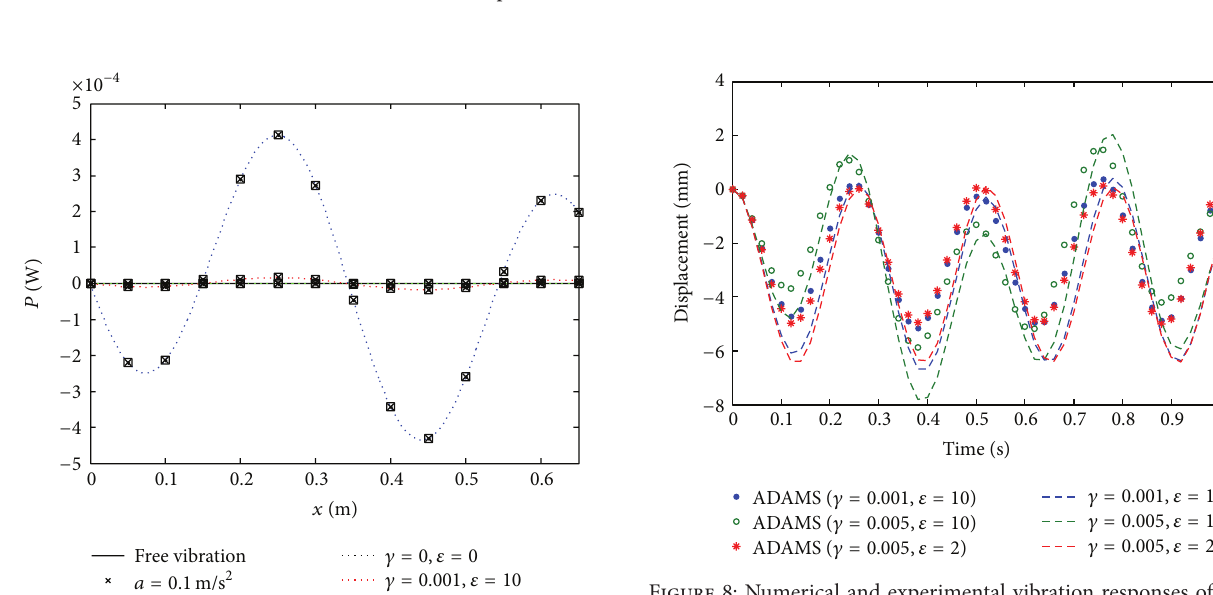
Figure 6: Vibration responses of the FMMB with disturbance accelerations.